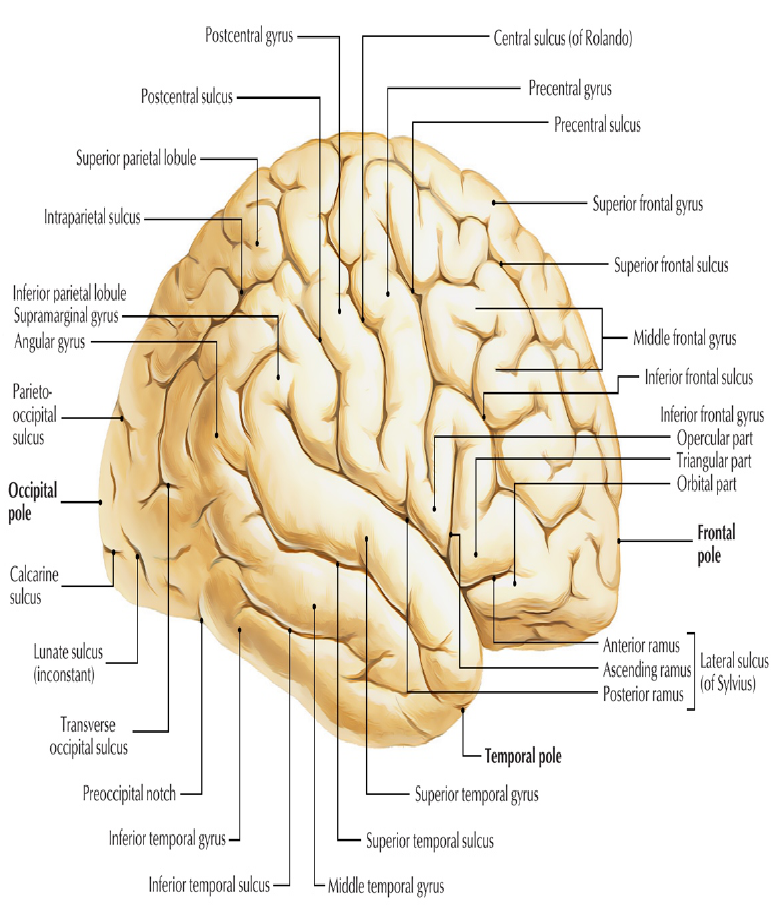
Figure 6. Some of the ROI of the brain